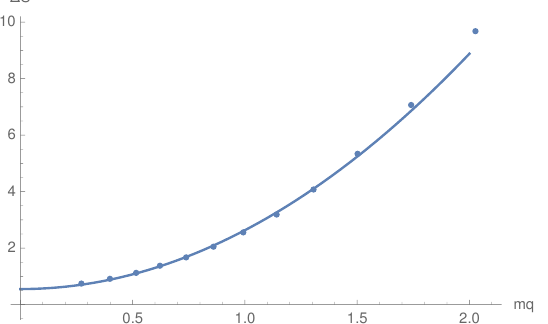
Figure 17 . Quadratic dependence of the instanton action (cid:1) S on the mass m q of the pair-produced quarks in the ‘in(cid:12)nite volume limit approximation’ in which one considers only loops near the boundary between region (i) and